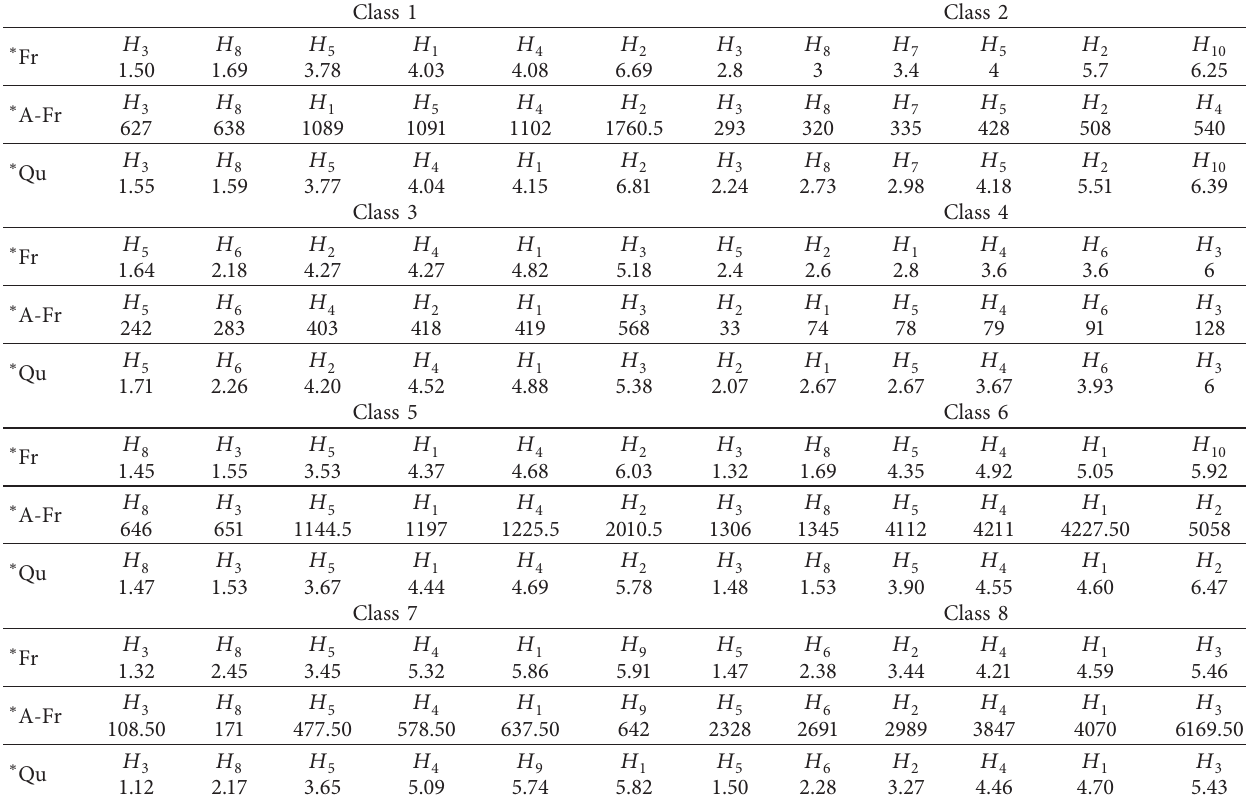
Table 15: Heuristics ranks per classes, Friedman (Fr), Aligned Friedman (A-Fr), and Quade (Qu). Class 1 Class 2